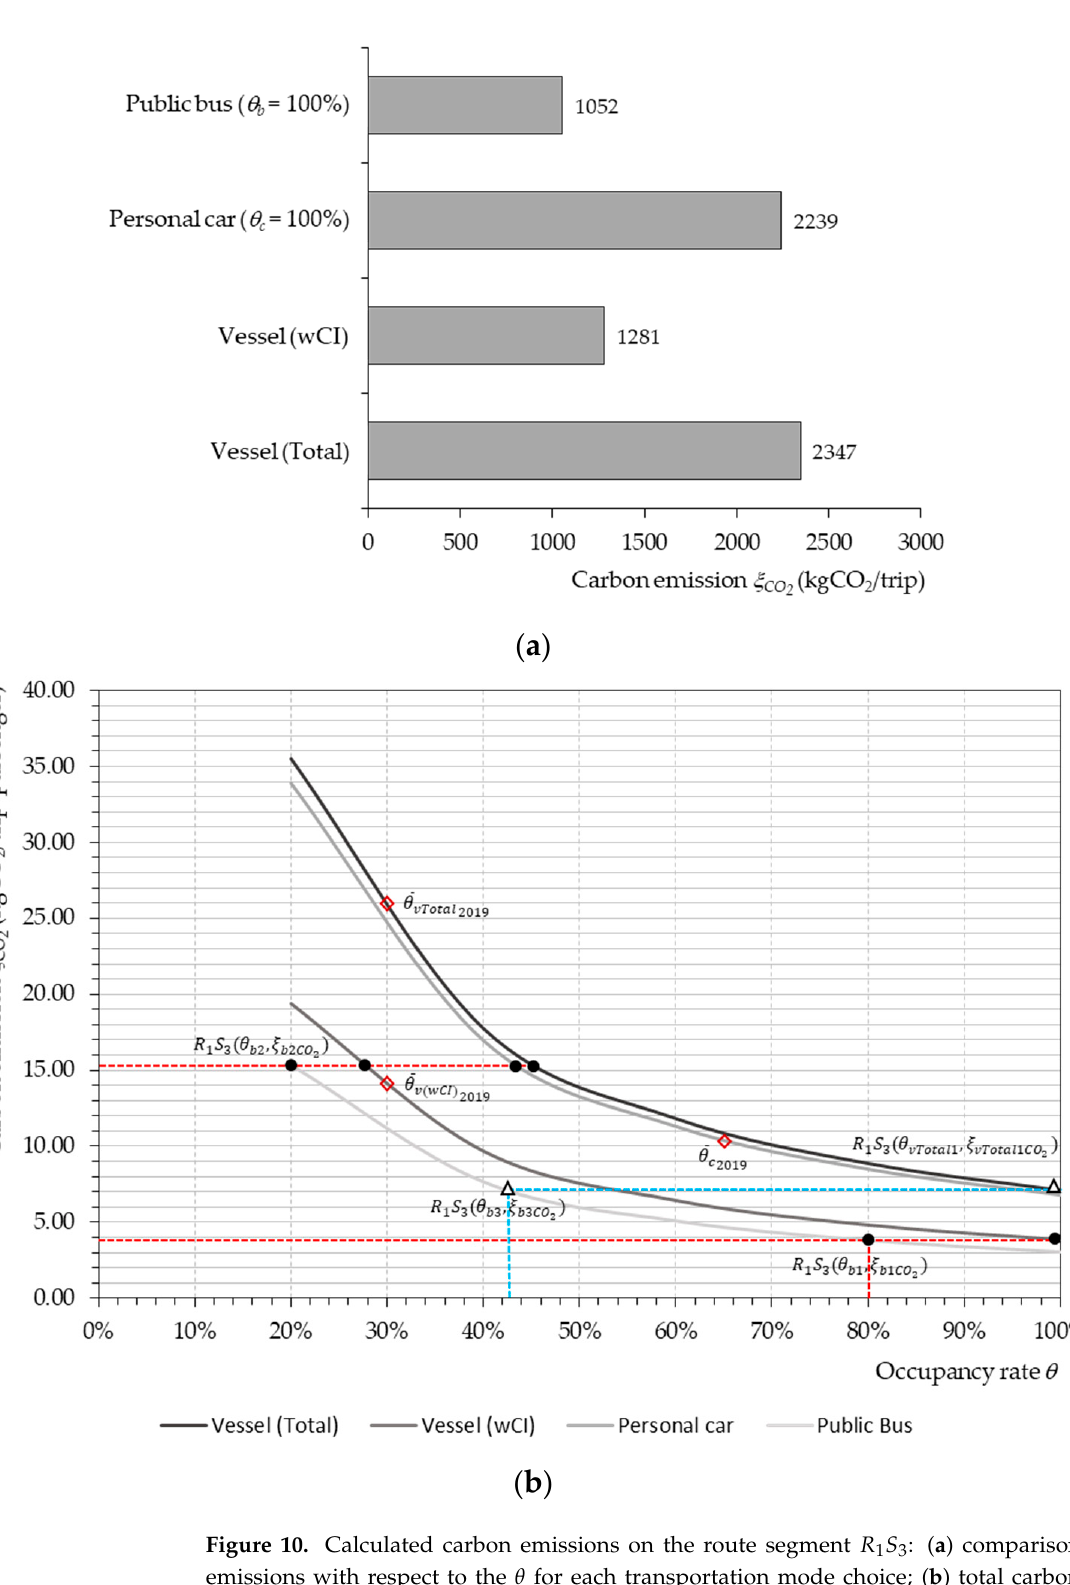
Figure 10. Calculated carbon emissions on the route segment R 1 S 3 : ( a ) comparison of carbon emissions with respect to the θ for each transportation mode choice; ( b ) total carbon emissions per single trip with respect to each transportation mode and based on the reference capacity of 330 passengers.